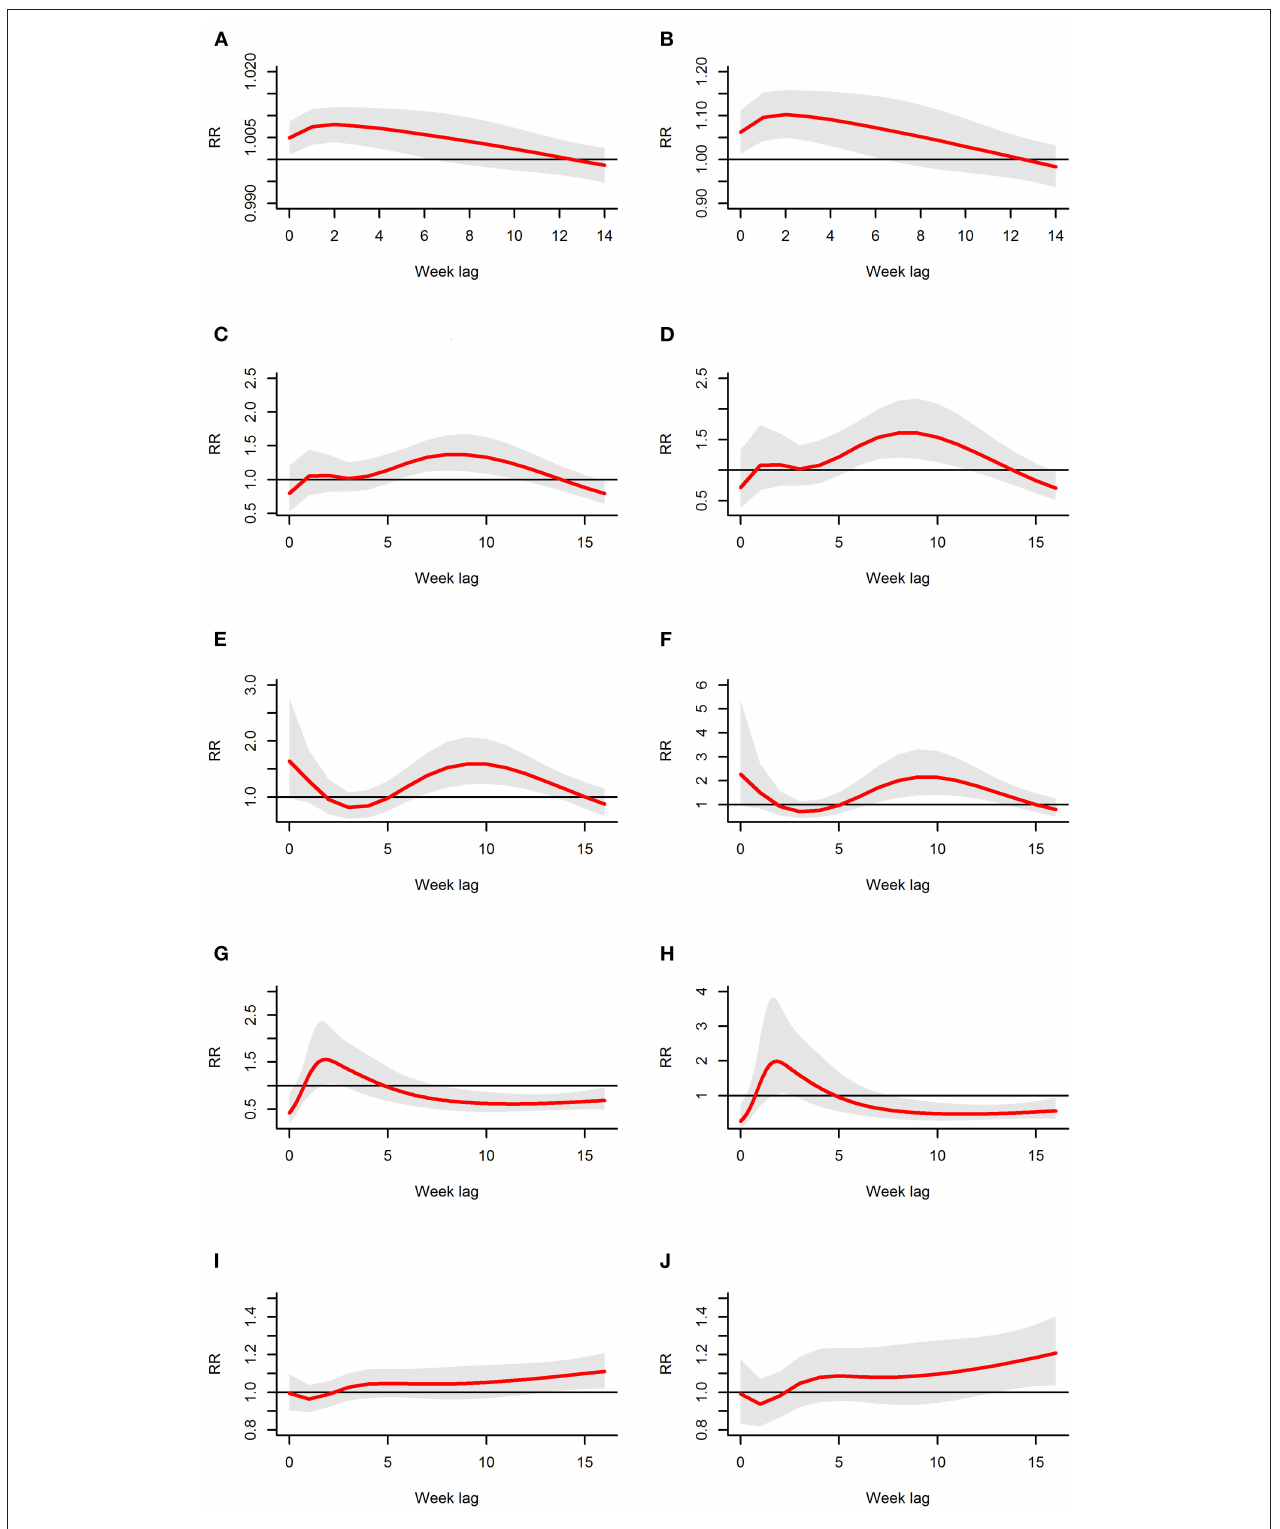
FIGURE 4 | The estimates of distributed lag between meteorological variables and scrub typhus cases. The relative risk for each weather variable is calculated at 50 and 75% exposure levels The estimated distributed lag association is the red line, and the shaded bands indicate its 95% CI. (A,B) Show the scenario for rainfall; (C,D) show the scenario for relative humidity; (E,F) show the scenario for land surface temperature; (G,H) show the scenario for air temperature; and (I,J) show the scenario for sunshine.